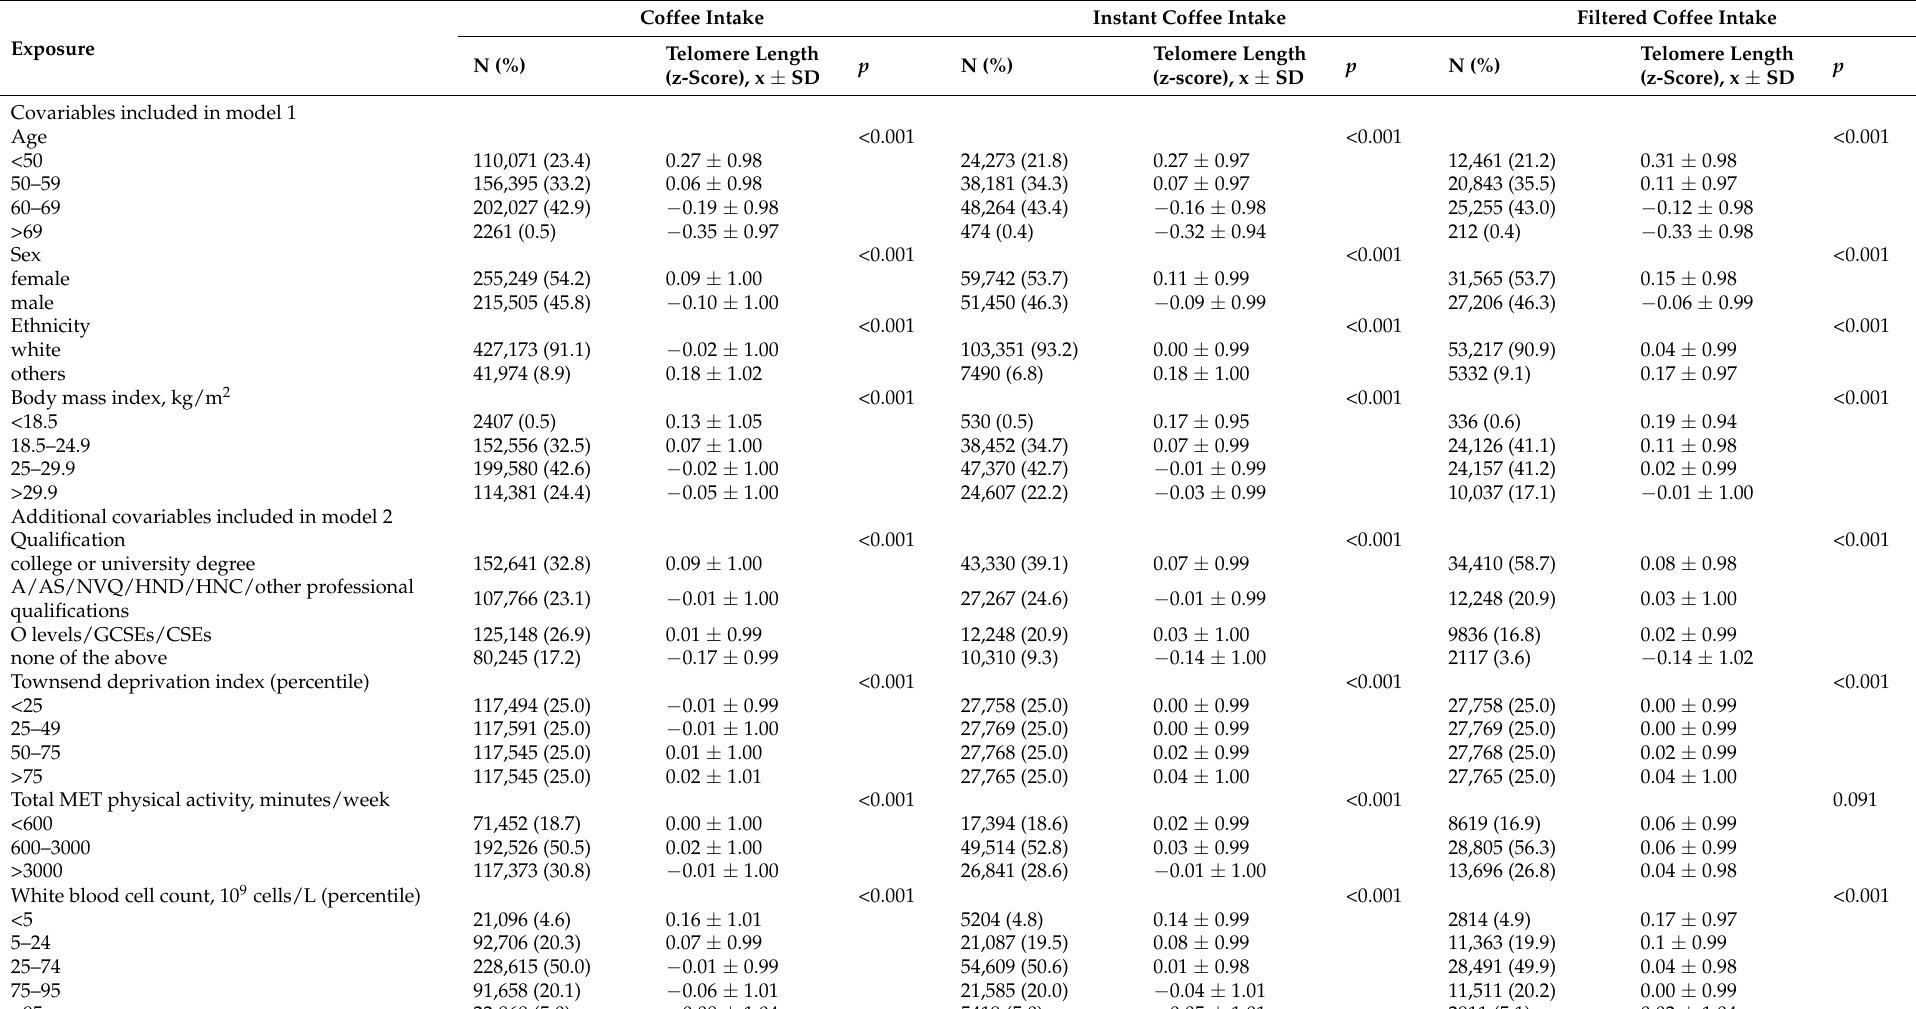
Table 1. Baseline characteristics by coffee consumption in the UK